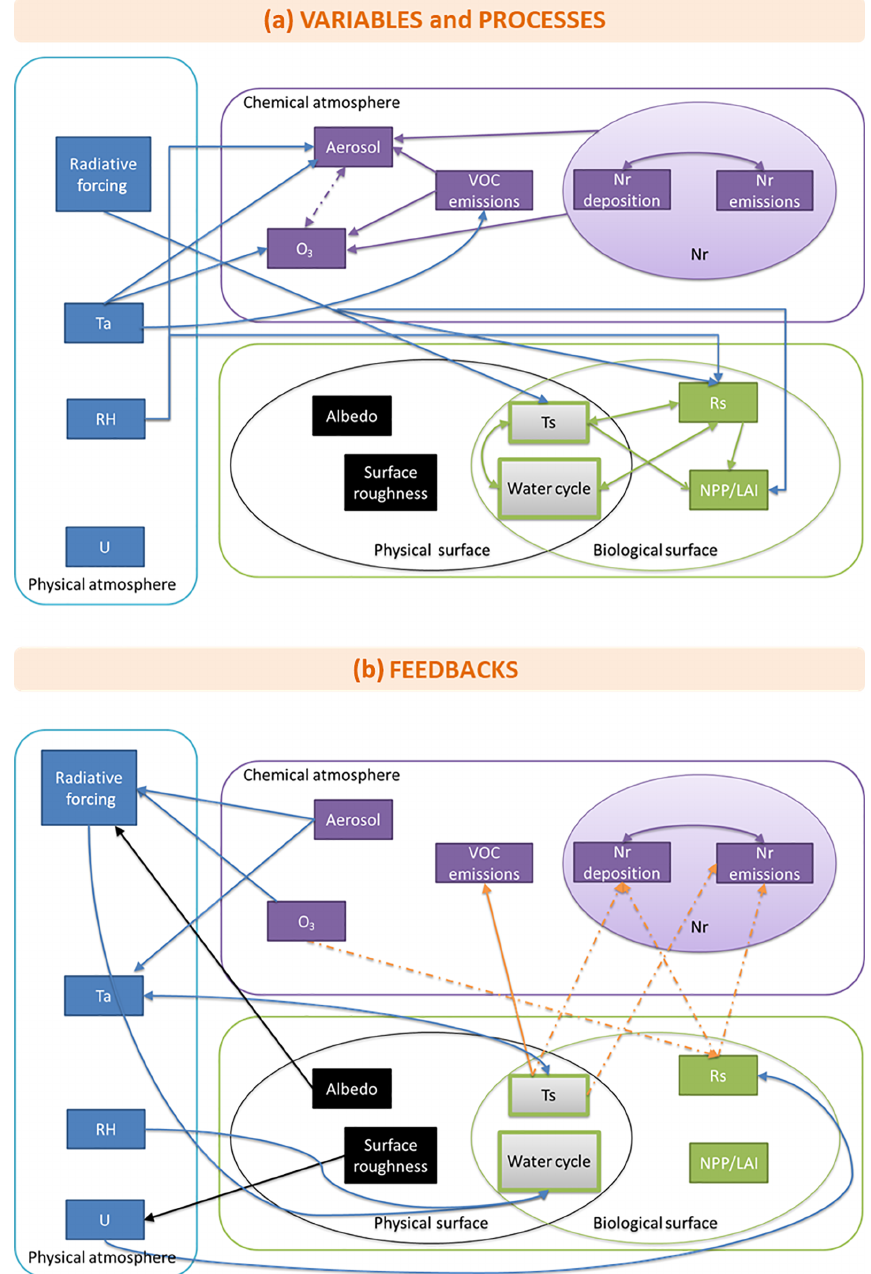
Figure 5. Interactions between the different variables and processes (a) concerned in biosphere–atmosphere exchanges as well as feed- backs (b) involved between the physical and biological surfaces of an ecosystem and the physical and chemical compartments of the adjacent atmosphere. Full arrows represent well-documented processes and feedbacks; dashed arrows represent mechanisms having knowledge gaps or badly represented in most models. N r stands for reactive nitrogen species, T a for air temperature, RH for air relative humidity, U for average wind speed, VOC for volatile organic compounds, T s for surface temperature, R s for stomatal resistance, net primary production (NPP) for net primary production, and LAI for leaf area index. This schematic covers most atmospheric variables discussed in the paper, but not all atmospheric variables that can be affected. Rainfall and cloudiness for example are amongst the ones that have been shown to be sensitive to land and are not discussed